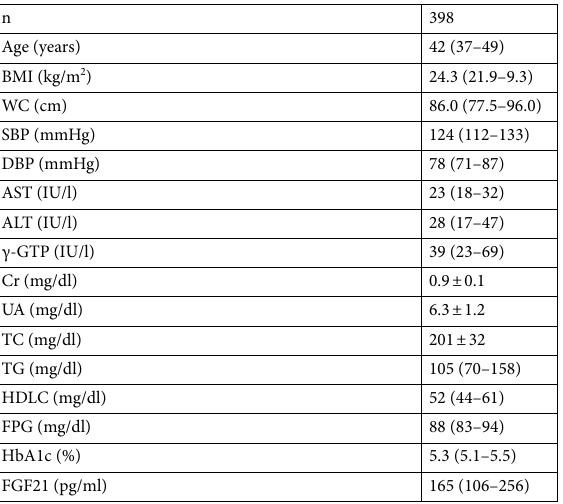
Table 1. Characteristics of the study subjects. Data are expressed as means ± SD or medians (interquartile range). BMI, body mass index; WC, waist circumference; SBP, systolic blood pressure; DBP, diastolic blood pressure; AST, aspartate aminotransferase; ALT, alanine aminotransferase; γ-GTP, gamma-glutamyl transpeptidase; Cr, creatinine; UA, uric acid; TC, total cholesterol; TG, triglycerides; HDLC, high-density lipoprotein cholesterol; FPG, fasting plasma glucose; FGF21, fibroblast growth factor 21.